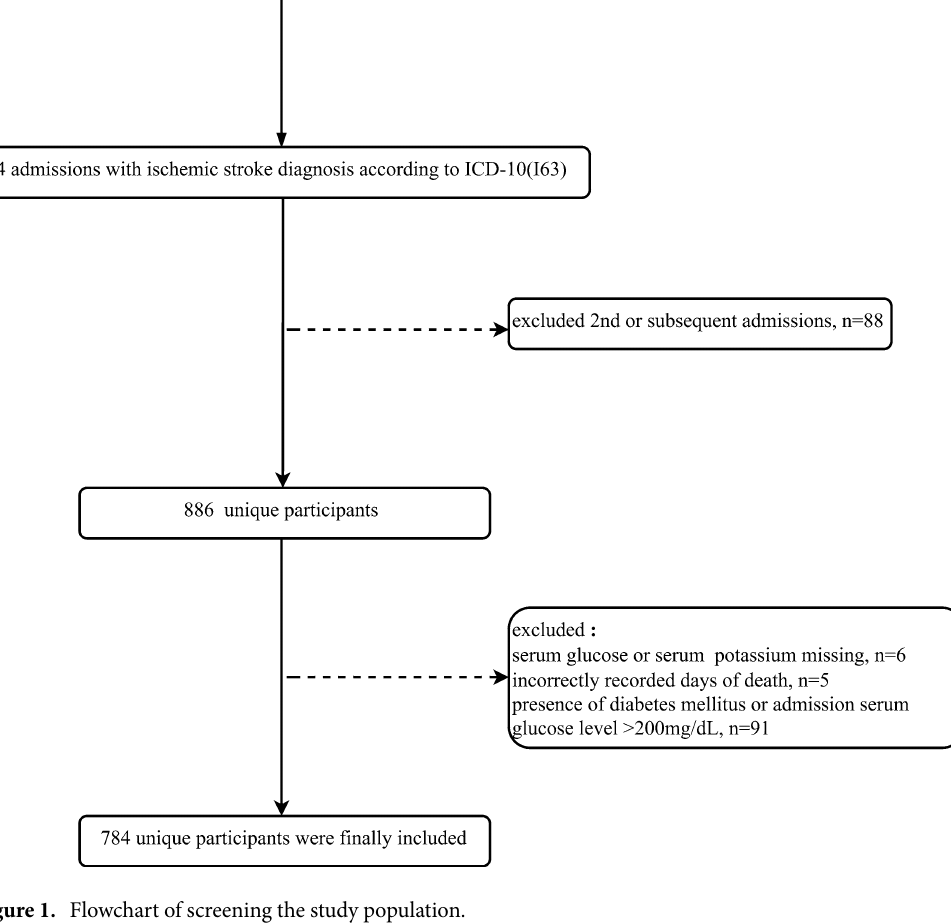
Figure 1. Flowchart of screening the study